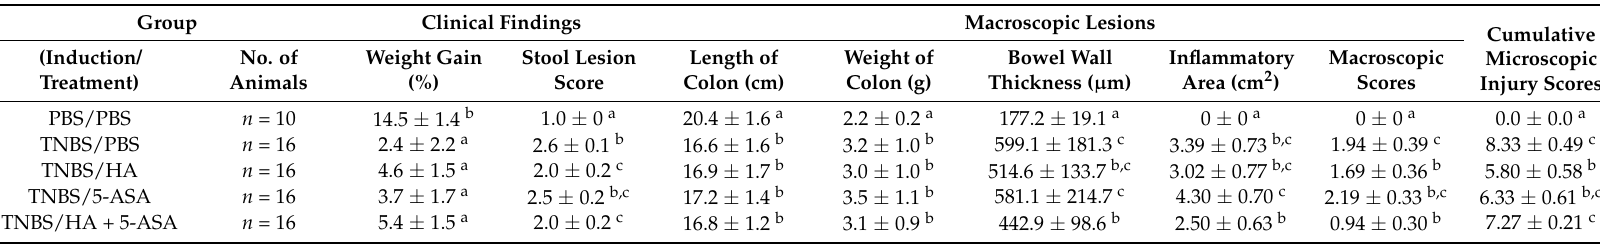
Table 1. Clinical findings and macroscopic and cumulative microscopic assessment of rats with colitis following induction (PBS or TNBS) and treatment (PBS, HA, 5-ASA, and HA +